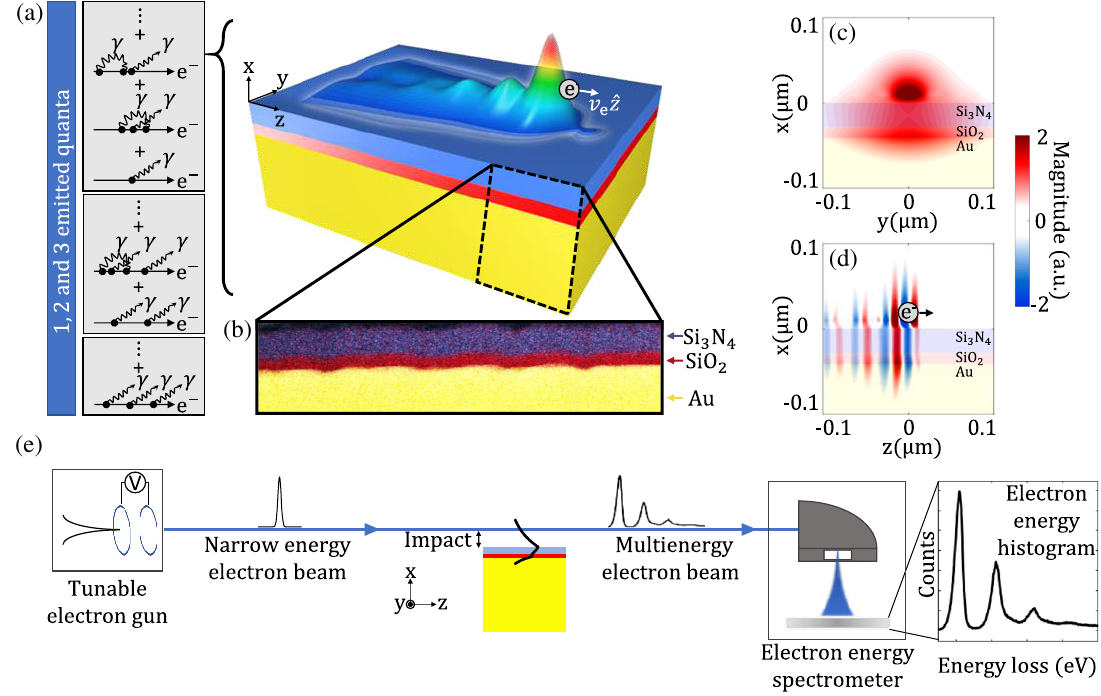
FIG. 2. The experimental setup for the 2D CR measurement. (a) Schematics of a free electron traveling above our metal-dielectric multilayer structure emitting 2D CR. The YZ cross section of the radiated electric field ( z component) is presented, highlighting its copropagation with the electron. The schematic represents the emission of a single quanta of PQP (exemplified by the Feynman diagrams of one-photon emission), which is part of the joint electron-photon quantum state. Higher-order processes are also possible as shown in the other Feynman diagrams. (b) Cross-section image of the metal-dielectric multilayer structure. Layers are presented in different colors according to an energy-dispersive x-ray (EDX) spectroscopy measurement (see Appendix A). (c),(d) The field distribution of the PQP created by 2D CR through its XY (c) and XZ (d) cross sections. To maximize the overlap with the free electron, the sample is engineered to support a confined (c) PQP with a large field distribution in its evanescent tail that extends out of the structure (d). (e) Illustration of the experiment, wherein an electron beam propagates parallel to the sample surface and emits multiple quanta of PQPs. The emission events are imprinted on the electron energy spectrum as discretized energy loss events measured in the EELS. The inset shows a characteristic EELS measurement, featuring three 2D CR peaks beyond the zero-loss peak. The distance between the electron beam centroid to the sample surface is the impact